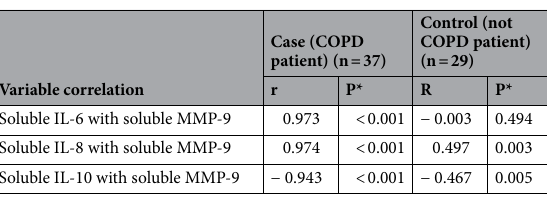
Variable correlation